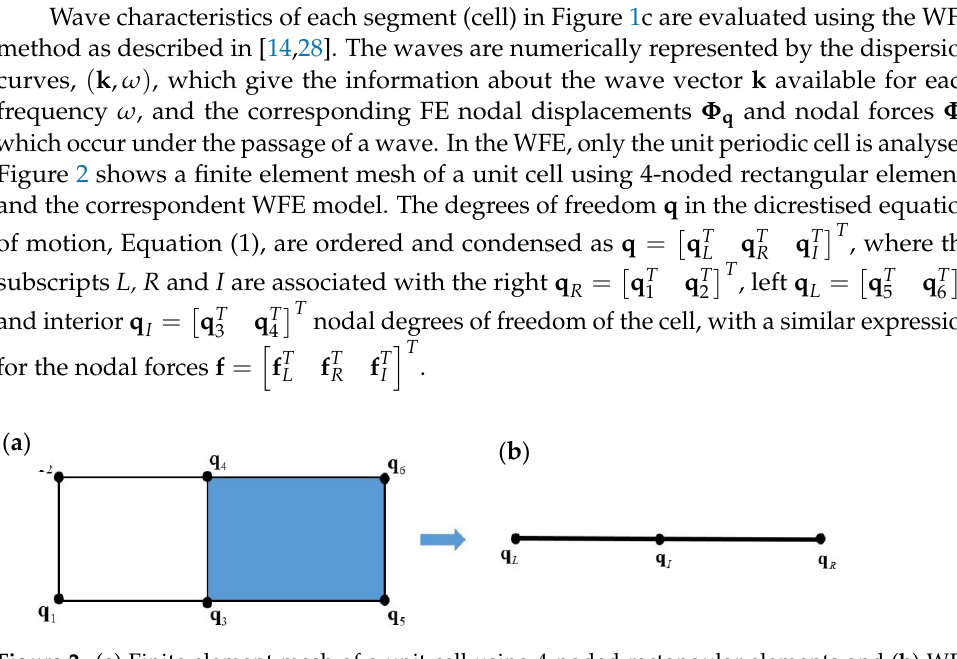
Figure 2. ( a ) Finite element mesh of a unit cell using 4-noded rectangular elements and ( b ) WFE nodes condensation.